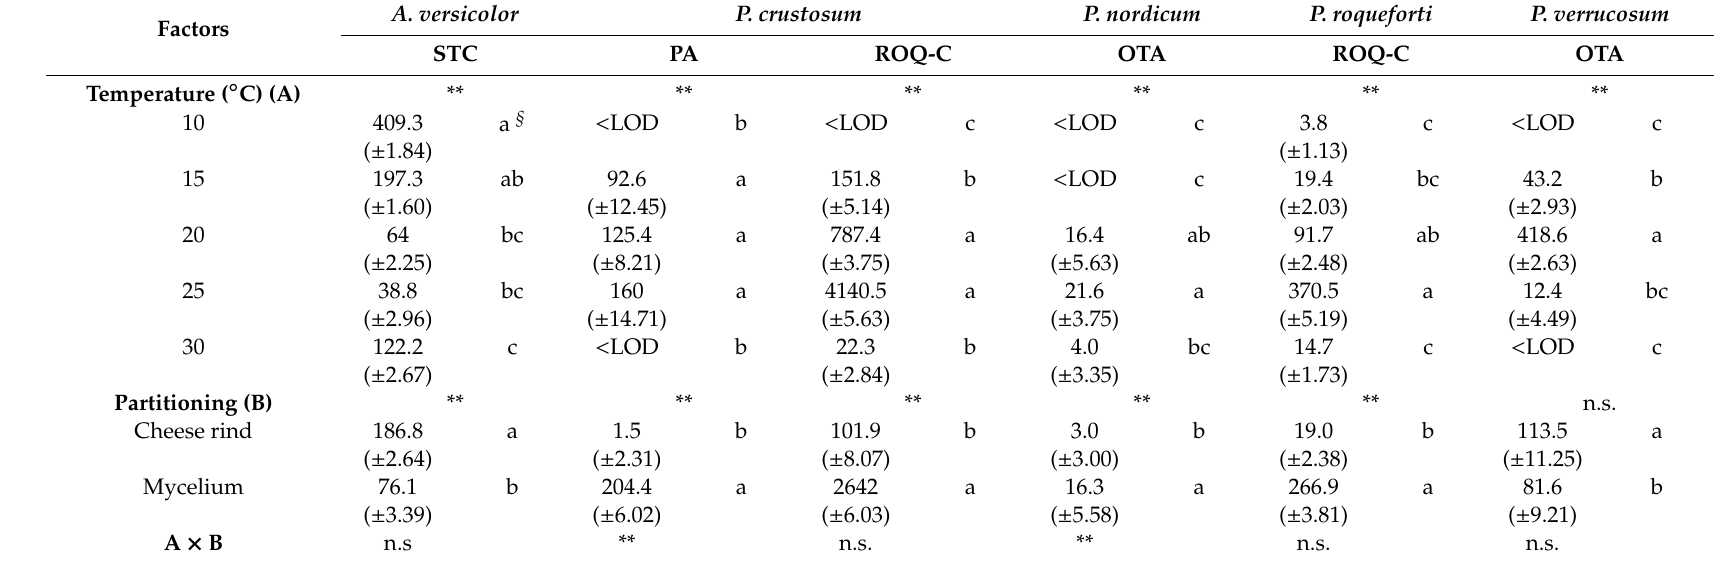
Table 3. Analysis of variance (ANOVA) for mycotoxin production (ng) in di ff erent regimes of temperature (10–30 ◦ C, step 5 ◦ C) and for di ff erent partitioning (cheese rind or mycelium). Standard deviation of mycotoxin were reported in